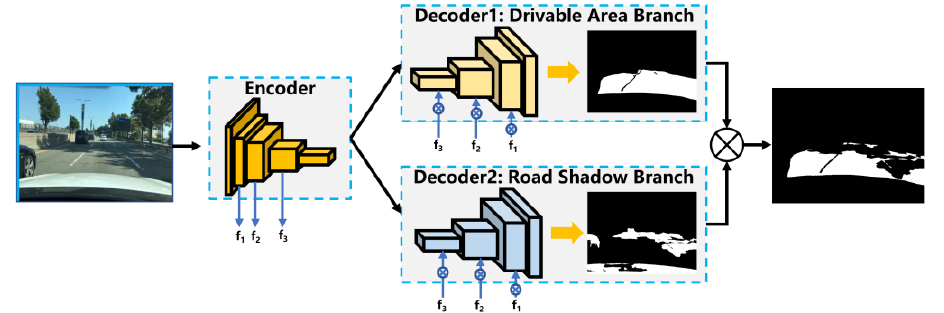
Figure 2. Road feature extraction network based on multi-task learning.